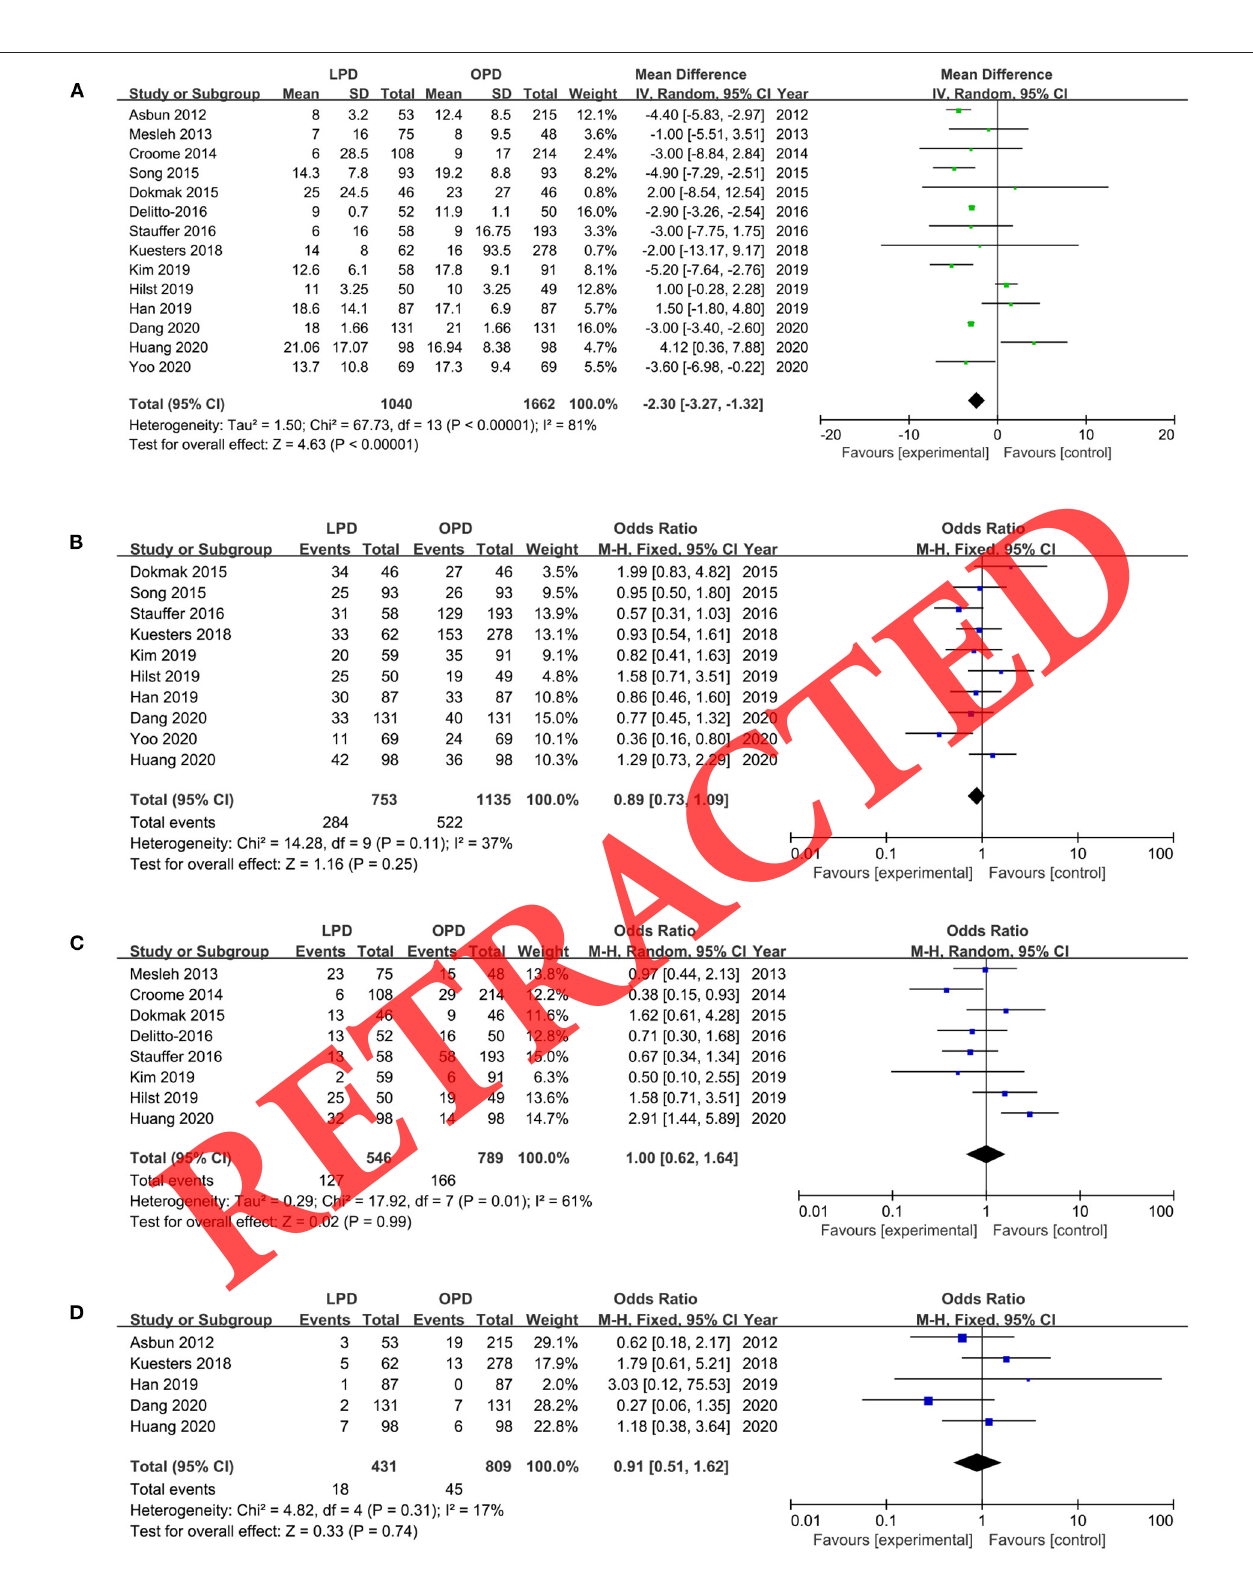
FIGURE 4 | Forest plot of comparison of LPD vs. OPD for postoperative outcomes. (A) Forest plot for operative time; (B) forest plot for overall complication rates; (C) forest plot for Clavien–Dindo grade ≥ III; and (D) forest plot for 90-day mortality.